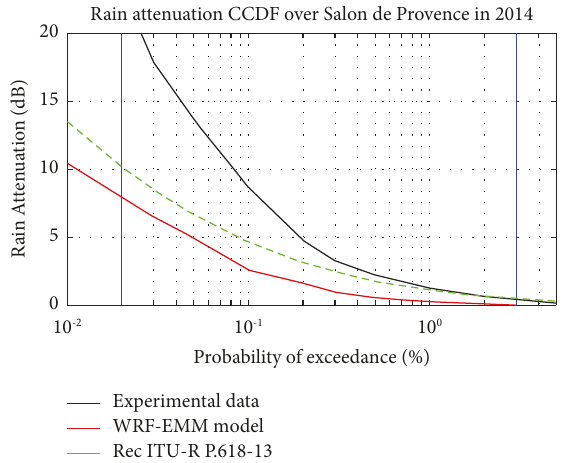
Figure 8: Comparisons between CCDFs computed from data measured in Salon de Provence in 2014 (94.7% availability), WRF- EMM simulations and Rec. ITU-R P.618–13 using R0.01 predicted with Rec. ITU-R P.837–7.